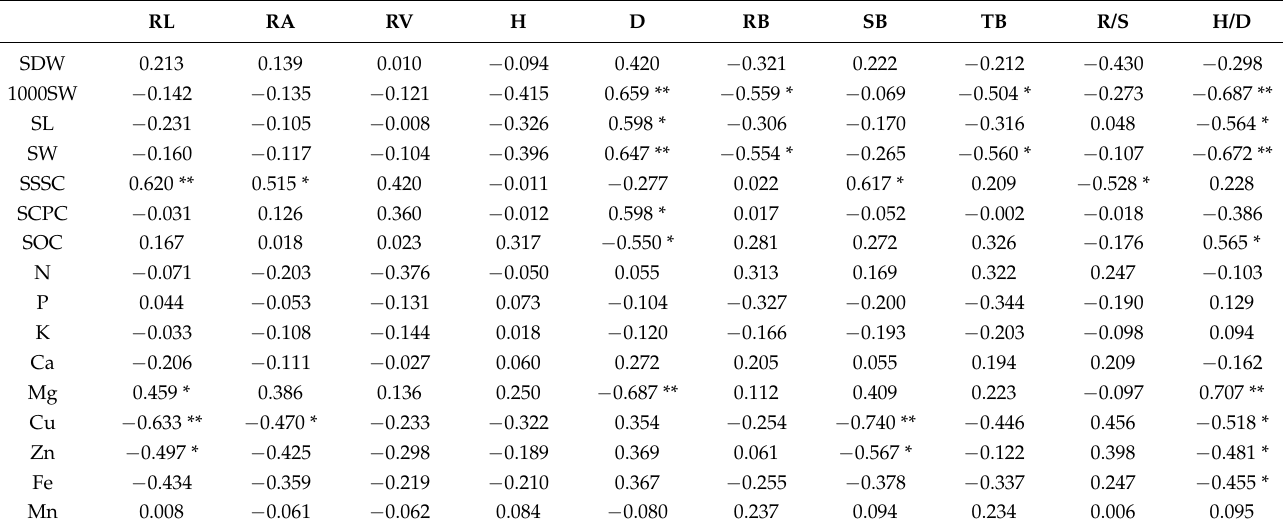
Table 13. Correlation coefficients between seed and seedling traits of four provenances of X. sorbifolium